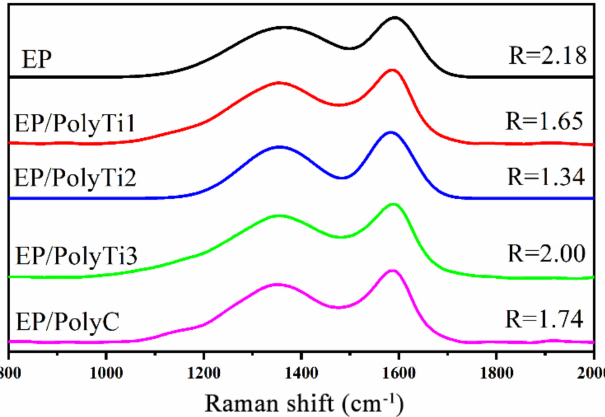
Figure 10. The Raman spectra of carbon residue of EP composites.